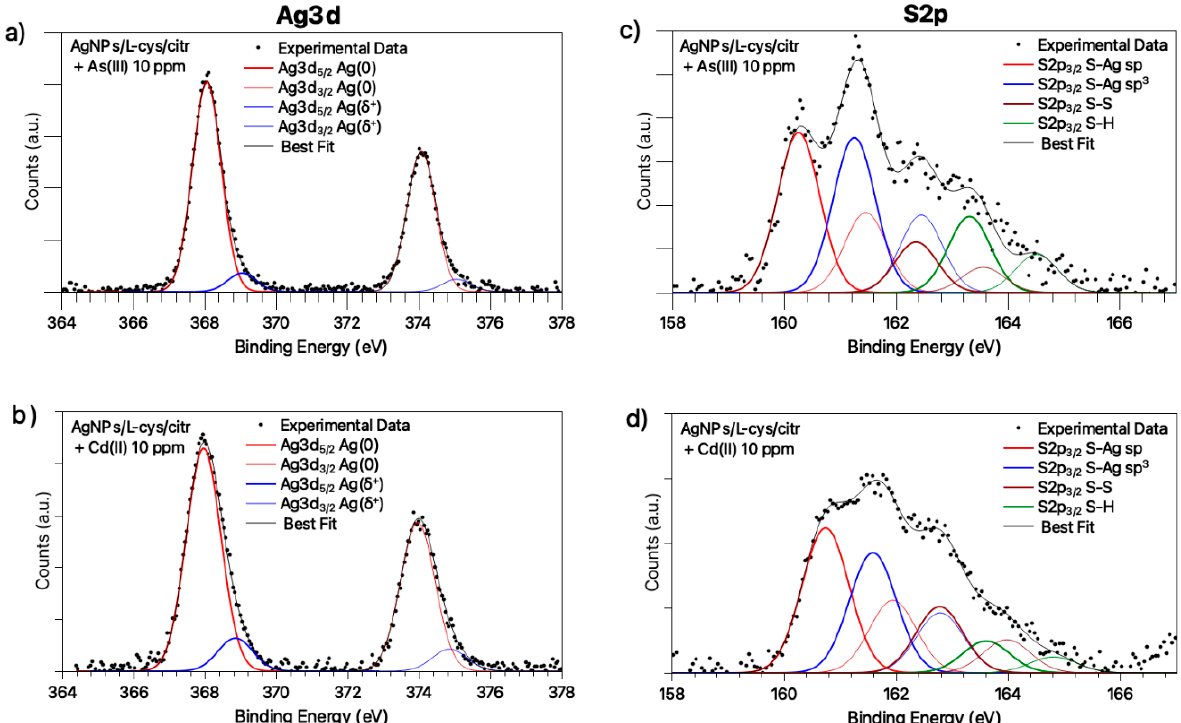
Figure 3. Ag3d core-level spectra of: ( a ) AgNPs/L-cys/citr + As (10 ppm), ( b ) AgNPs/L-cys/citr + Cd (10 ppm); S2p core-level spectra of: ( c ) AgNPs/L-cys/citr + As (10 ppm), ( d ) AgNPs/L-cys/citr + Cd (10 ppm). Table 2. BE (eV), FWHM (eV), Atomic percentage and Proposed Assignment for Ag3d and S2p spectral components. Sample Signal BE (eV) FWHM (eV) Atomic % Assignment 368.09 Ag3d 5/2 368.51 AgNPs/L-cys/citr + As (10 ppm)